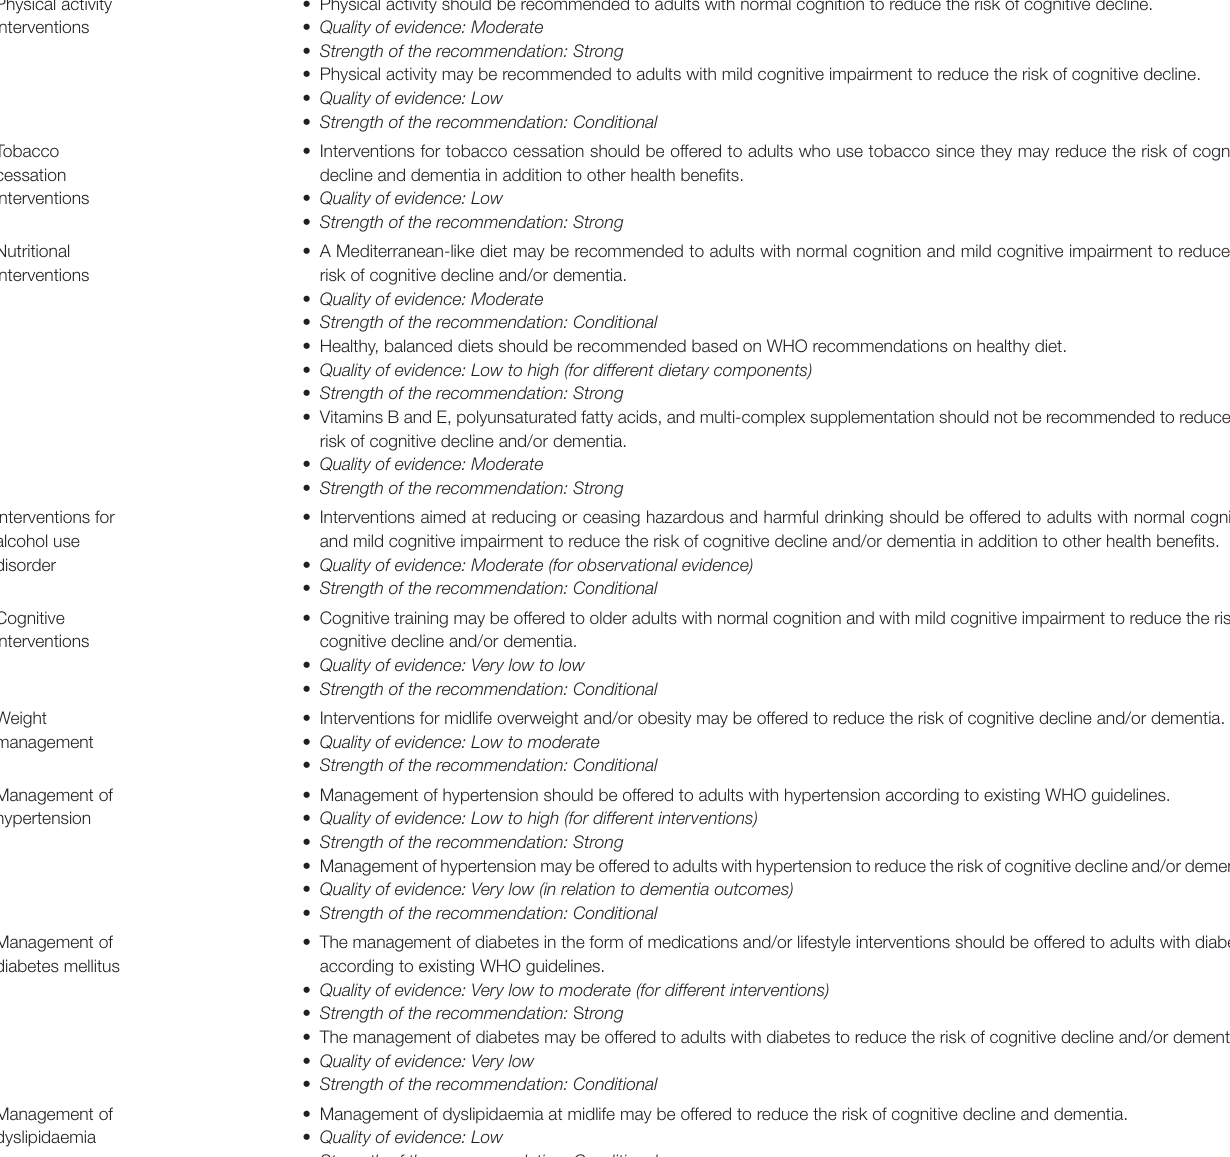
TABLE 1 | WHO recommendations for risk reduction of cognitive decline and